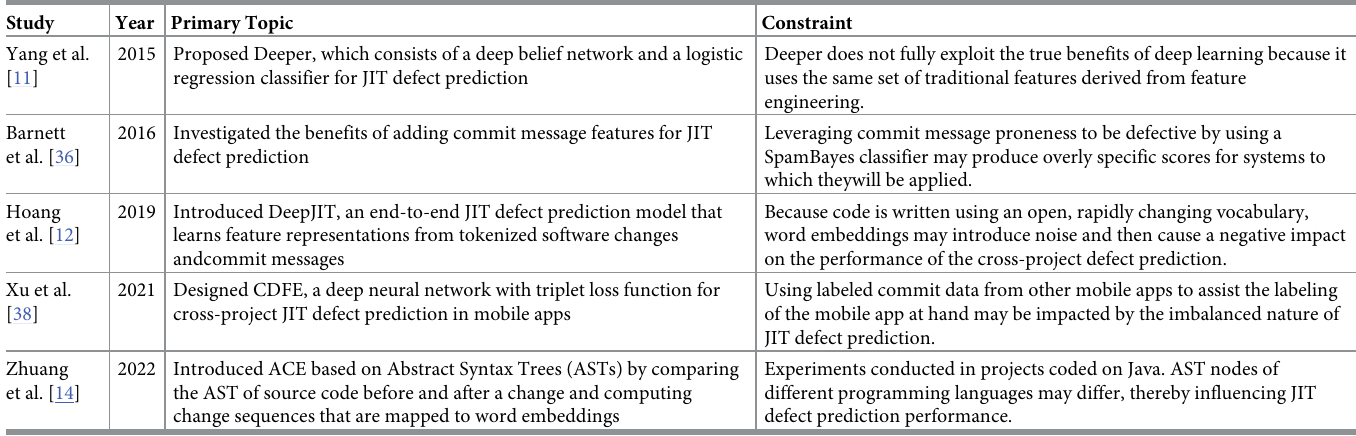
Table 1. Summary of JIT defect prediction works by using feature